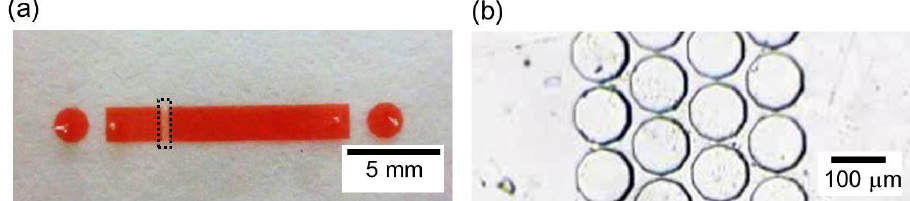
Figure 6. Fabricated microfluidic device. ( a ) Top view of the fabricated microfluidic device filled with water, colored with red food dye to improve visibility. The dashed rectangular line shows the position of the micropillar array. ( b ) Magnified image of the micropillar array shown in the dashed line rectangular of the figure ( a ). The diameter of each micropillar is 100 μm and the interval between the micropillars is 5 μm